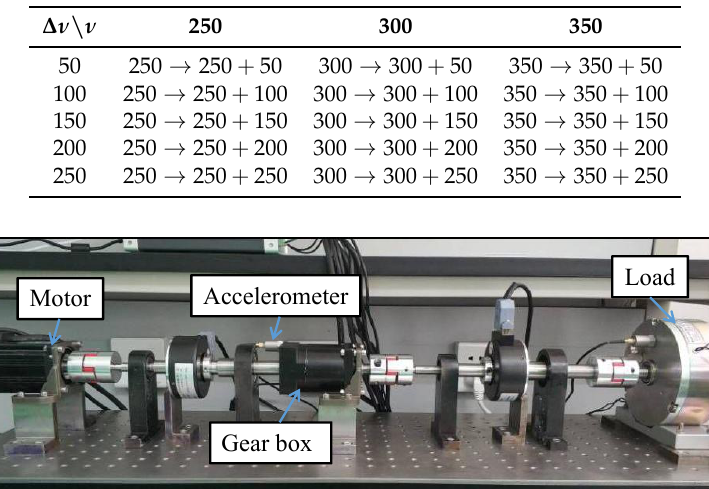
Table 4. Simulated speed condition change ν → ν + ∆ ν rpm.